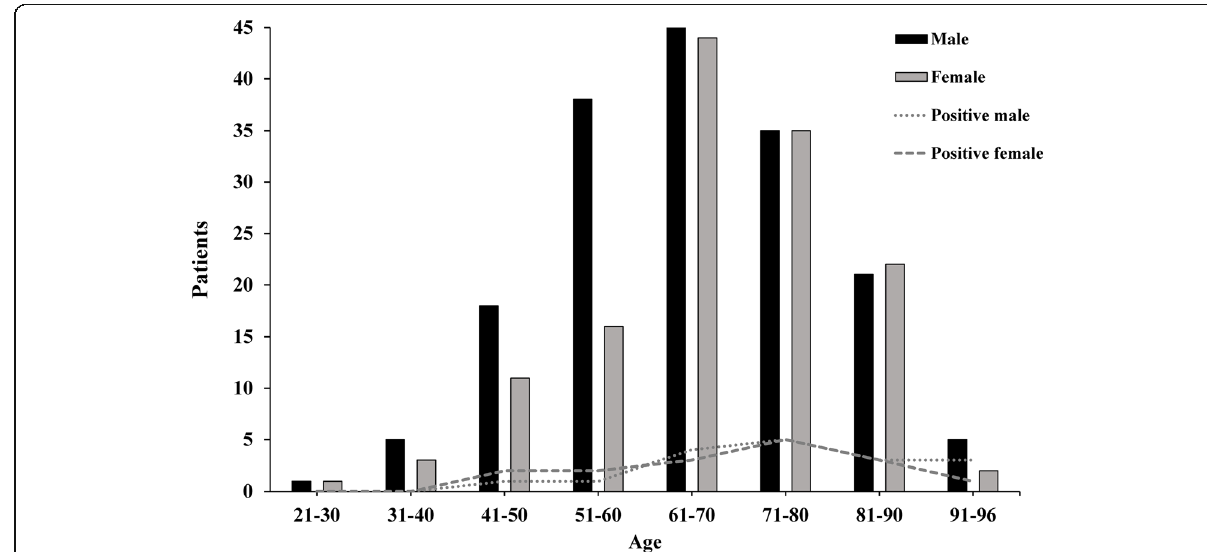
Fig. 1 The numeric comparison of all COVID-19 patients, by age and gender, and the subgroup with positive PCR test in conjunctival sac